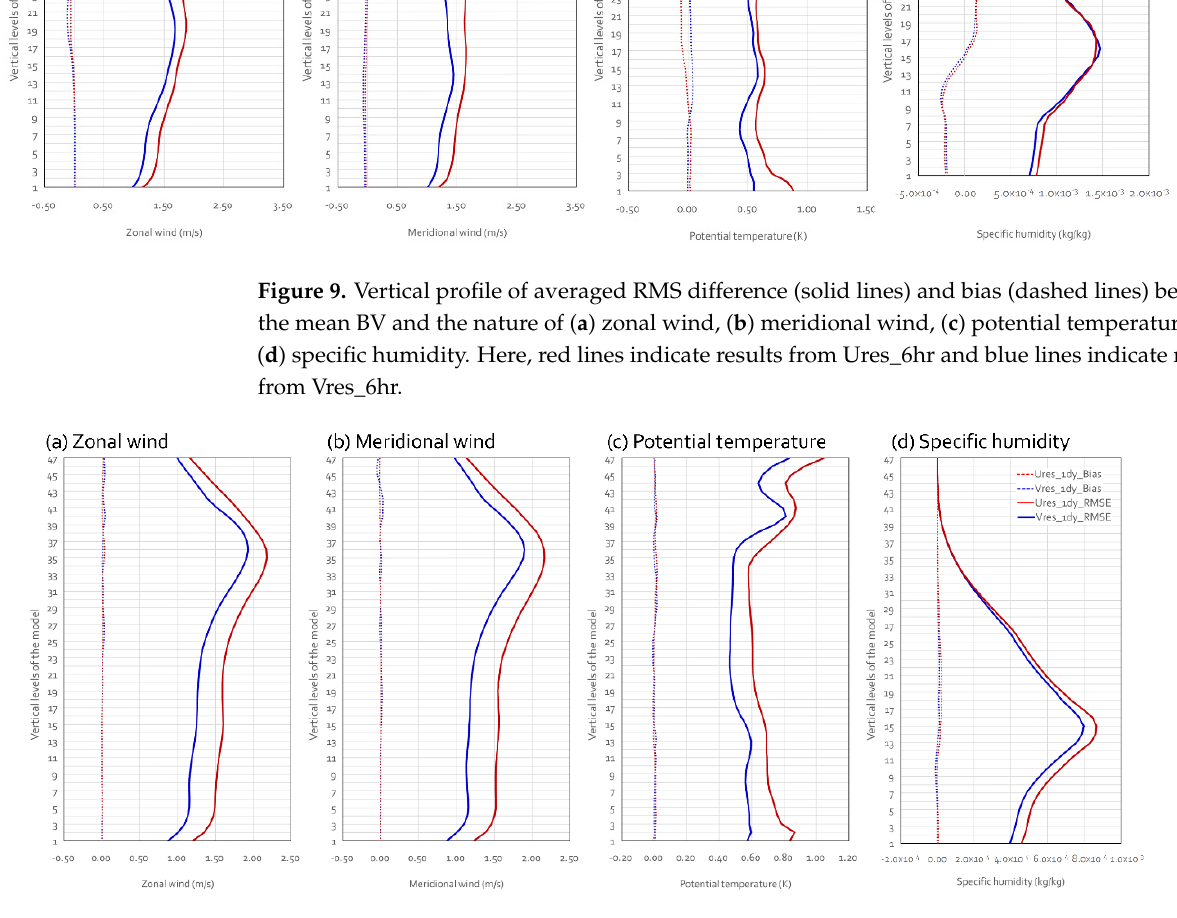
Figure 10. The same as Figure 9, except that red lines indicate results from Ures_1dy and blue lines indicate results from Vres_1dy. Table 3. RMS errors of averaged bred vectors for atmospheric three-dimensional variables from the nature